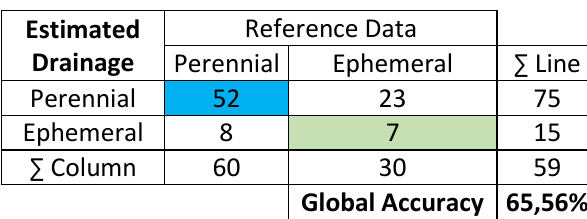
Table 2 – Accuracy Assessment of Estimated Drainage base in